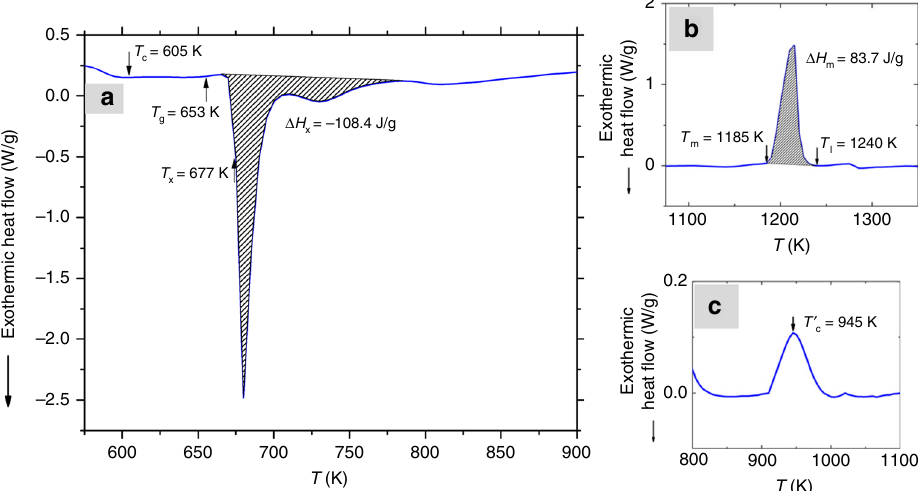
Fig. 2 Thermal properties of Fe 50 Ni 30 P 13 C 7 BMG. The glass transition T g , crystallization temperature T x , Curie temperature T c , and heat of crystallization DH x are provided in ( a ). The melting temperature the Curie temperature of the magnetic crystalline phases formed during the quenching and/or heating step is defects, distance of the sample from the center of the compression fi xtures) 32,33 . Severe deformation can be observed speci fi cally for the samples indicated by blue and red curve. The height of the